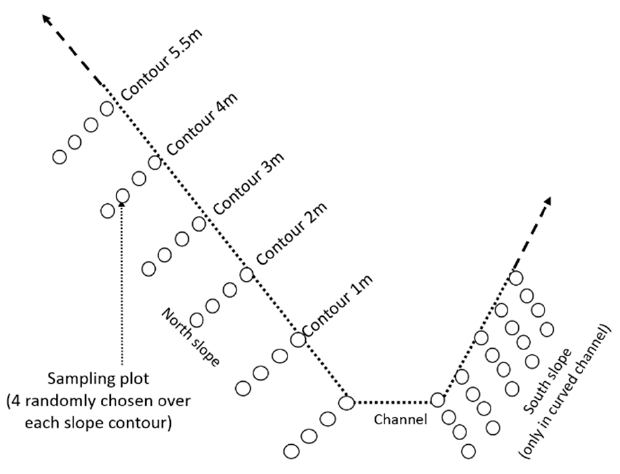
Figure 3. Sampling scheme of herbaceous biomass and soil over the WOS transects.